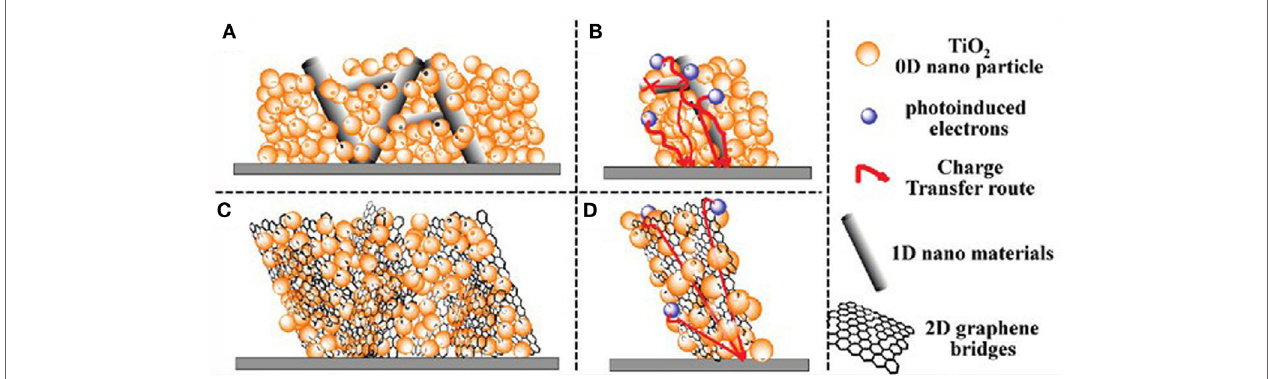
FiGURe 12 | Comparison of material loading and electron transport across CNT (A,C) and through graphene sheets (B,D) (Yang et al., 2010). Copyright ACS Publications, 2010.